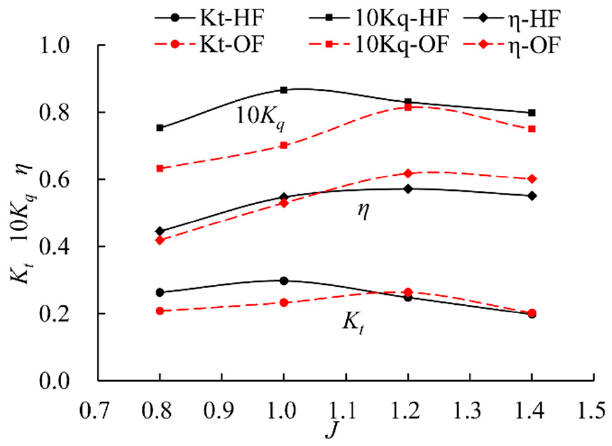
Figure 12. Open water performance of SPP-1 in horizontal flow (HF) and oblique flow (OF).